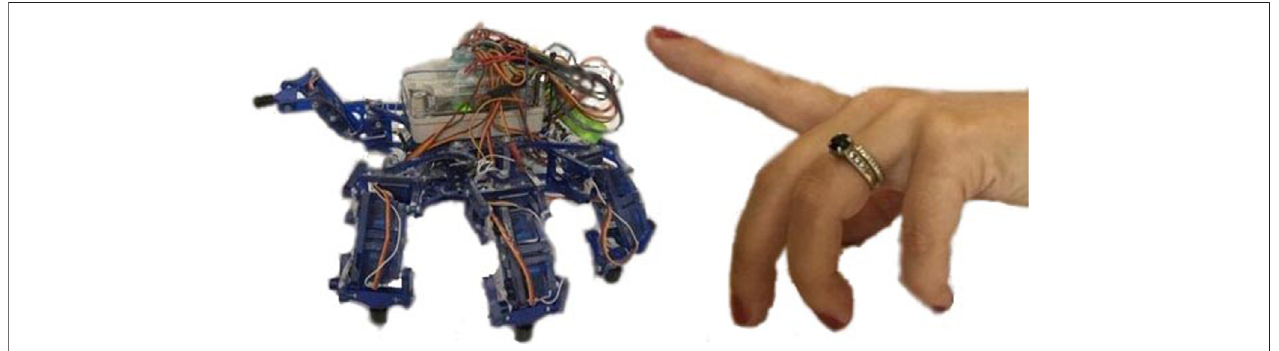
FIGURE1| Hexapodrobots(left)andhumanhands(right)havesimilaritiesthatcanbeconvenientforuserinterfaces.Forexample,ausermightwanttouseasingle fi ngerto lift a single leg of this crab-like hexapod (Bjelonic et al., 2016; Franchi et al., 2012; Carpentier and Mansard, 2018; Grezmak et al., 2021; Graf et al., 2019; Graf et al., 2021).